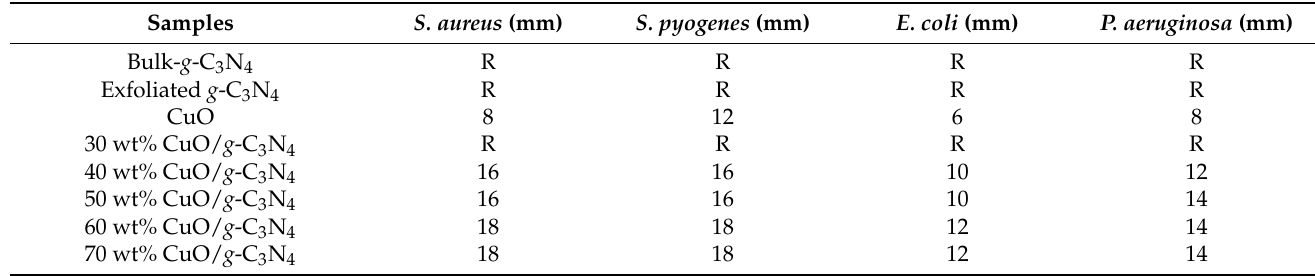
Table 1. Antimicrobial activity of cupric oxide/g-C 3 N 4